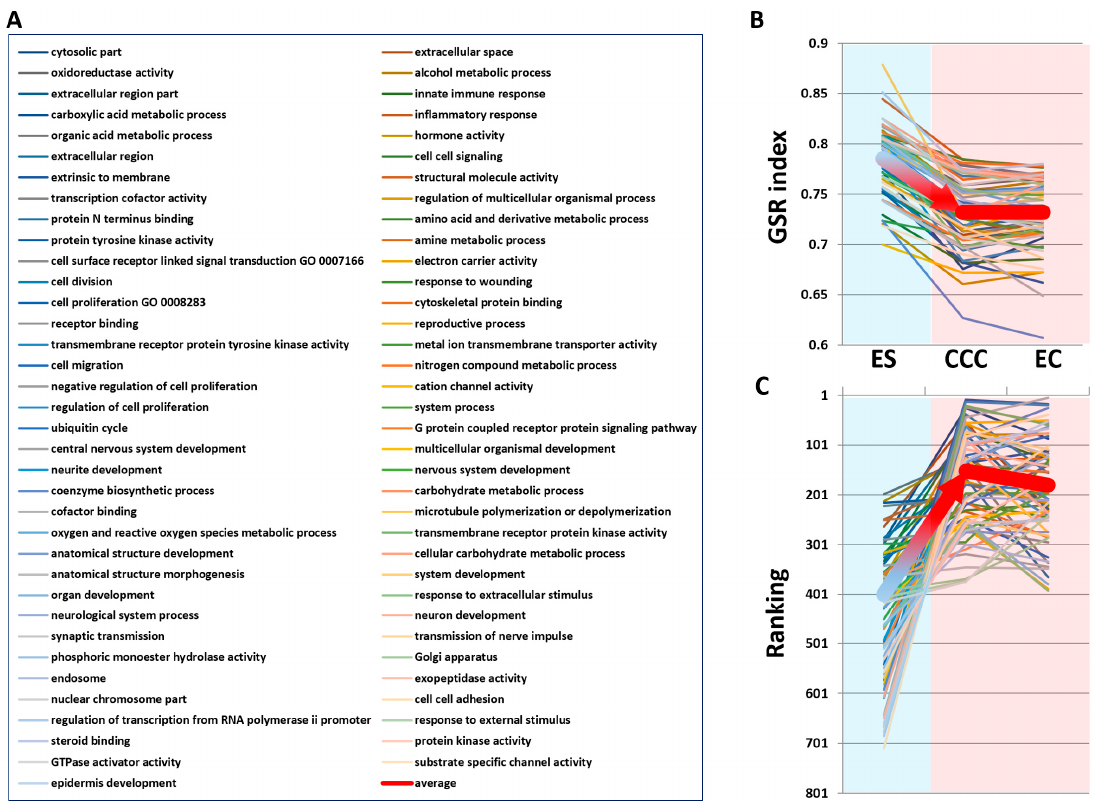
Figure 8. The 71 progressively-deregulated GO terms involving malignant transformation and their changes in GSR index and ranking from ES to CCC or EC. ( A ) The list of 71 progressively-deregulated GO terms whose GSR indices decreased and moved upward in rankings with the progression from ES to EAOC. ( B ) The GSR index levels of the 71 GO terms that decreased from ES to CCC or EC. ( C ) The ranking paths of the 71 GO terms changing from ES to CCC or EC. The coarse red line shows the paths for the average of the GSR indices ( B ) or rankings ( C ).